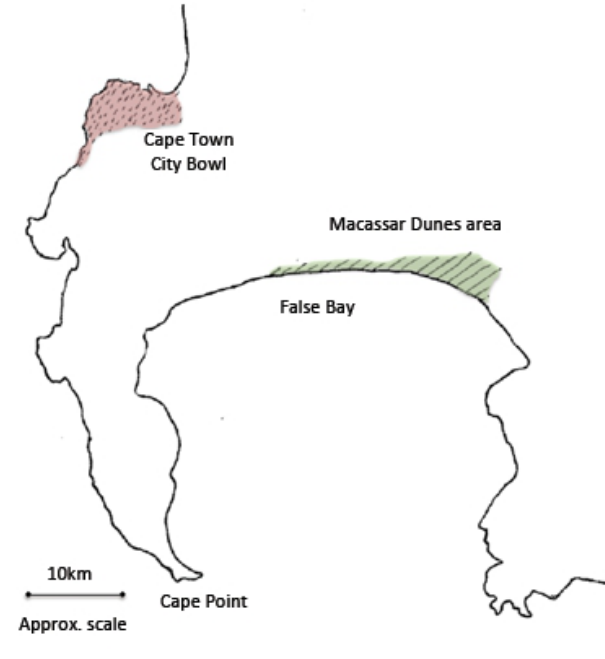
Fig. 1 . Location of Macassar Dunes in relation to Cape Town City Bowl (city center). (Map not to exact